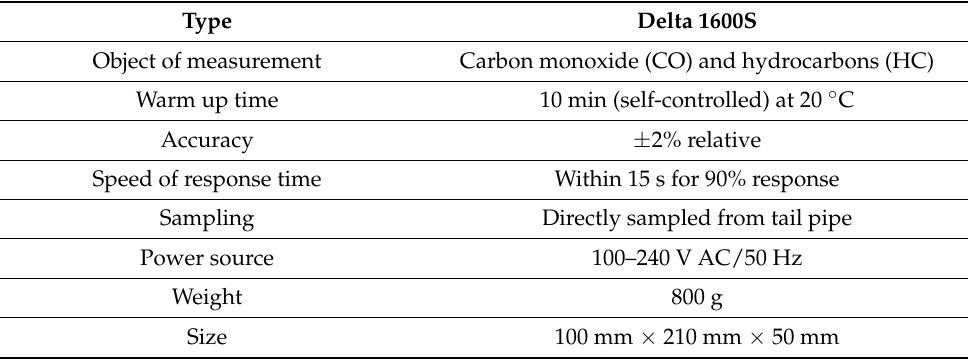
Table 4. Specifications of exhaust gas analyzer.